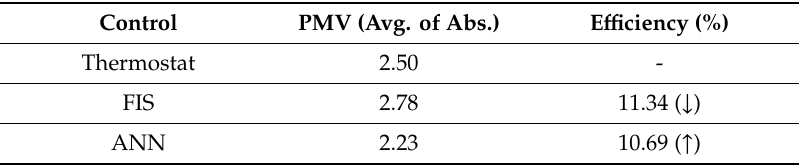
Table 2. Comparison of each thermal comfort.